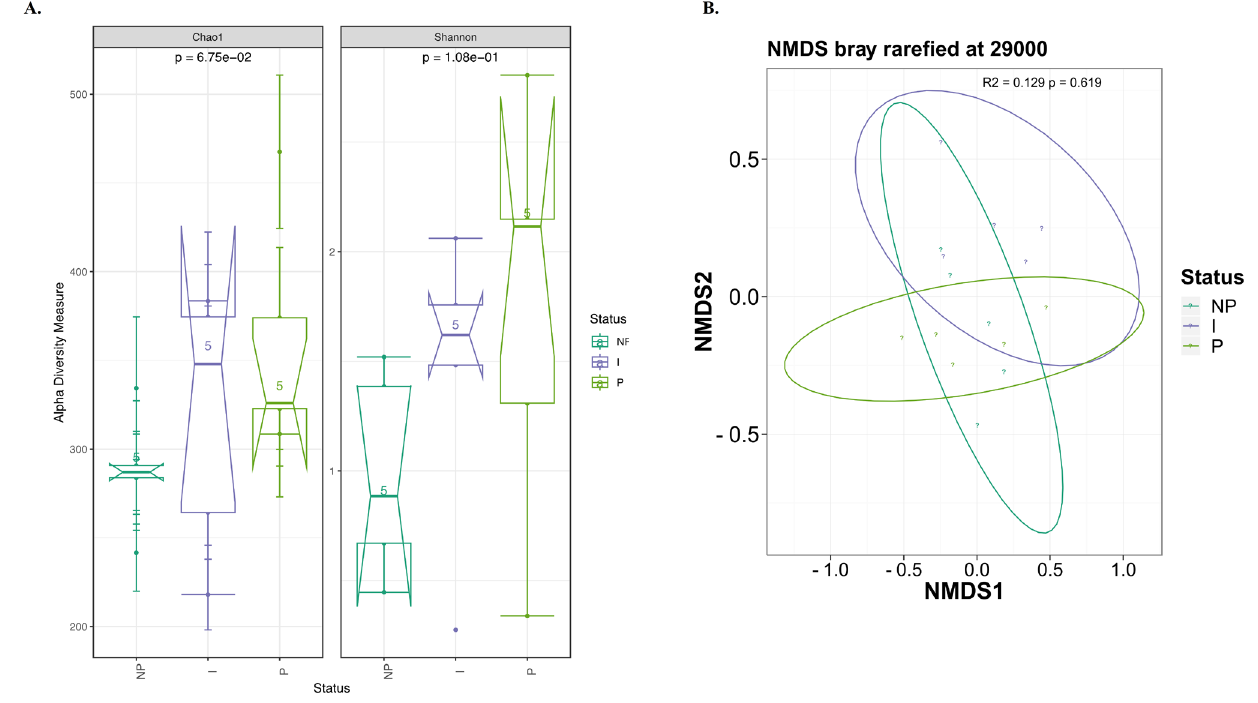
Figure 2. Alpha and beta diversity of bacterial composition of nasal samples. ( A ) Alpha-diversity, measured by Chao1 and Shannon diversity Index, is plotted for individuals with different S. aureus carrier status: non-carriers (NP, dark green), intermittent carriers (I, purple) and persistent carriers (P, light green). The Chao1 index (left panel) and Shannon index (right panel) were computed for all 15 subjects. The line inside the box represents the median, while the whiskers represent the lowest and highest values within the 1.5 interquartile range (IQR). Statistical testing showed no significant differences among the groups: Chao1 p = 0.0675; Shannon p =0.108. ( B ) Comparison of beta-diversity of bacterial composition between S. aureus carriage groups with NMDS ordinance calculated from Bray–Curtis distance estimation. I: Intermittent, NP: non-carrier, P: